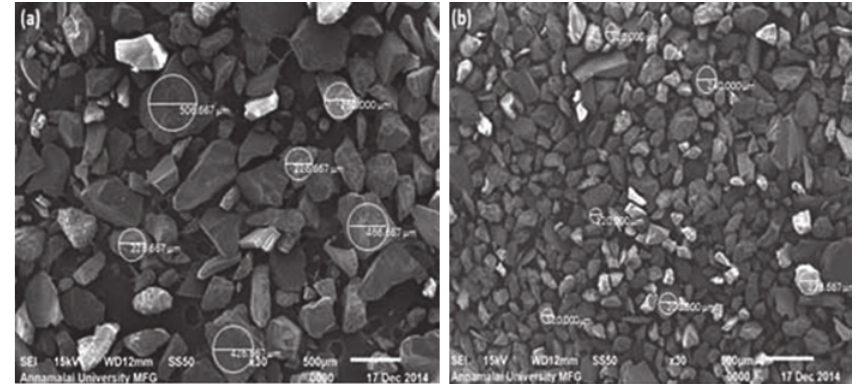
Figure 7: Scanning electron micrograph of silica sand.